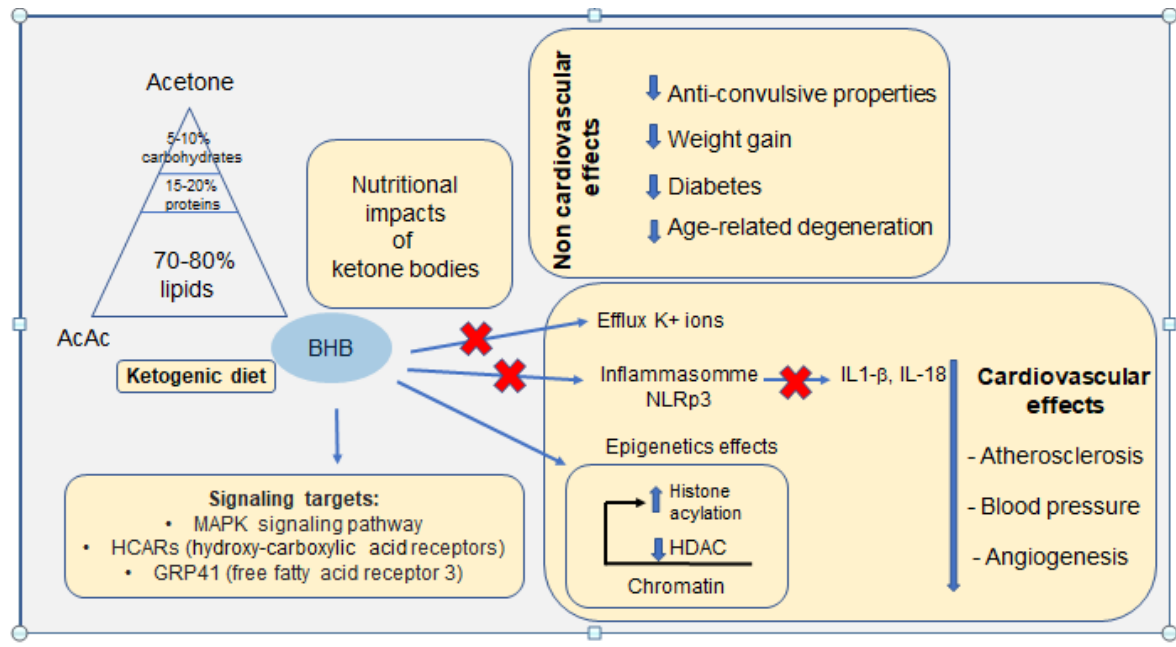
Figure 3. Schematic representation of the main links between the ketogenic diet on proven non-cardiovascular effects and physiological adaptations of the cardiovascular system. Recently identified signalling targets are also reported.